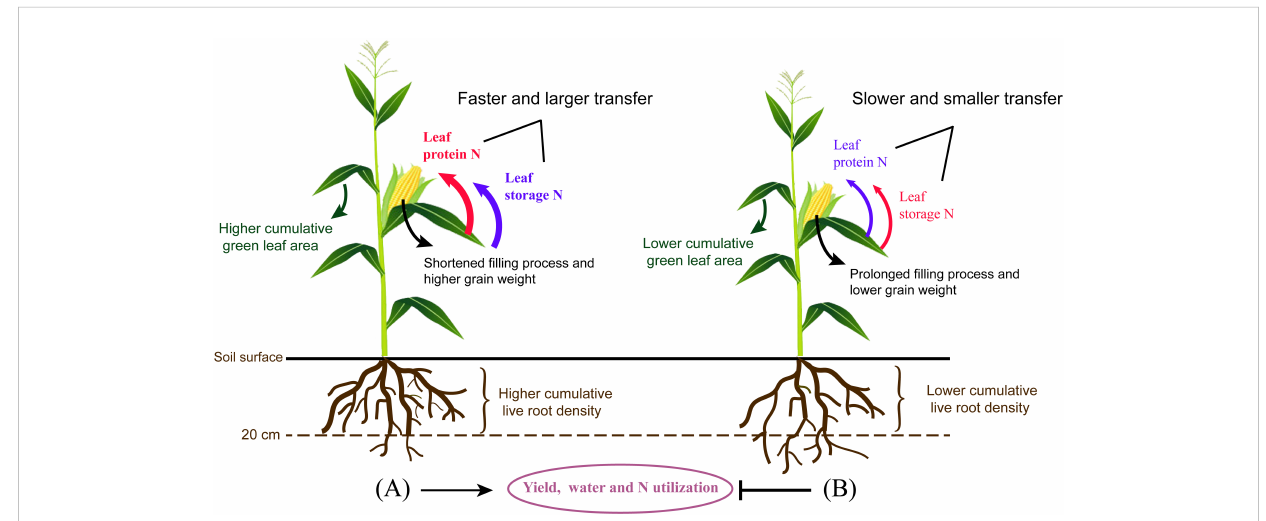
FIGURE 9 The comparison of drip irrigation under fi lm mulch (A) and drip irrigation incorporating straw returning (B) during the reproductive stage of maize. In contrast to (B) , (A) showed a higher cumulative green leaf area and live root density in the top 0- to 20-cm soil layers, but a lower cumulative live root density in the deeper soil layers. In addition, larger N was fast transferred from leaves to grains, accompanied with a shortened fi lling process and higher grain weight, which contributed to the improvement of yield, water, and N utilization for (A) . Non-protein storage N transfer was stimulated by (B) to make up for the relative inadequacy of leaf N. In the comparison between (A, B) , the red and bule font represent higher and lower translocation ef fi ciency for different N components,